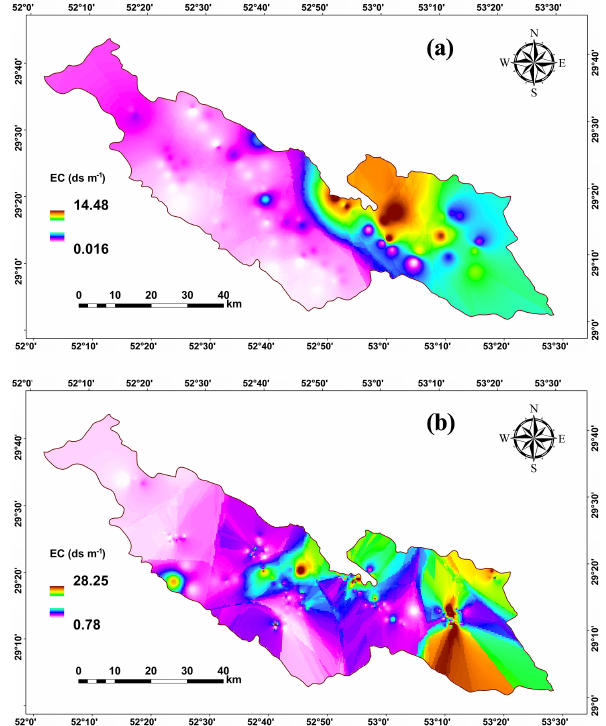
Figure 5. Interpolated maps of study area for (a) water and (b) soil